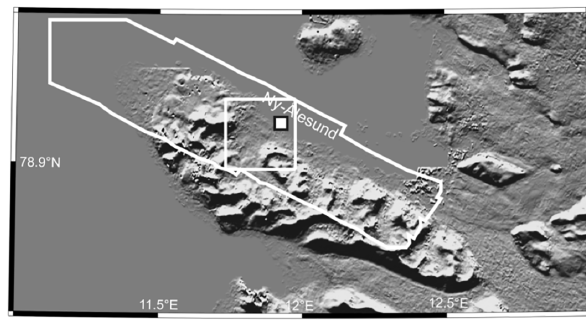
Figure B3. Context map of the Brøgger peninsula, with the thick white outline showing the total coverage of the HRSC-AX survey and with the white square indicating the location of the image tile provided in this publication (base map: hillshade version of ASTER DEM).